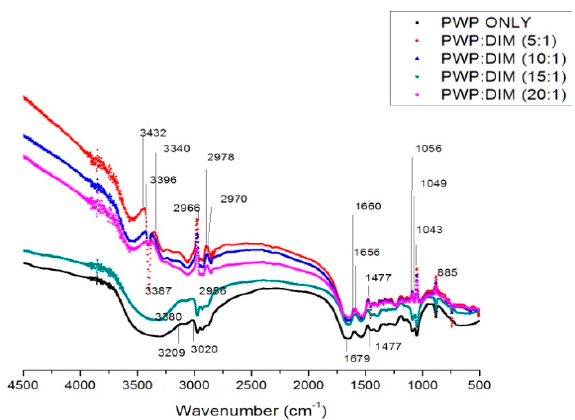
Figure 2. FT-IR spectra of PWP and PWP/DIM nanoparticles.